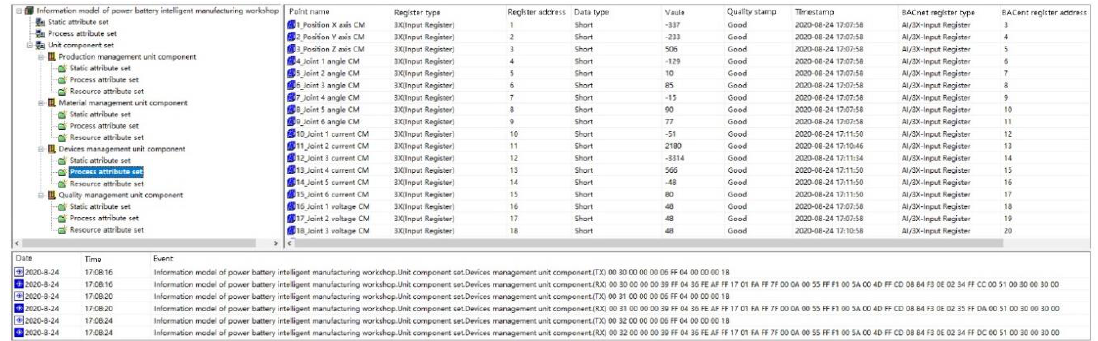
Figure 11. Partially results test of information model mapping to OPC UA server.